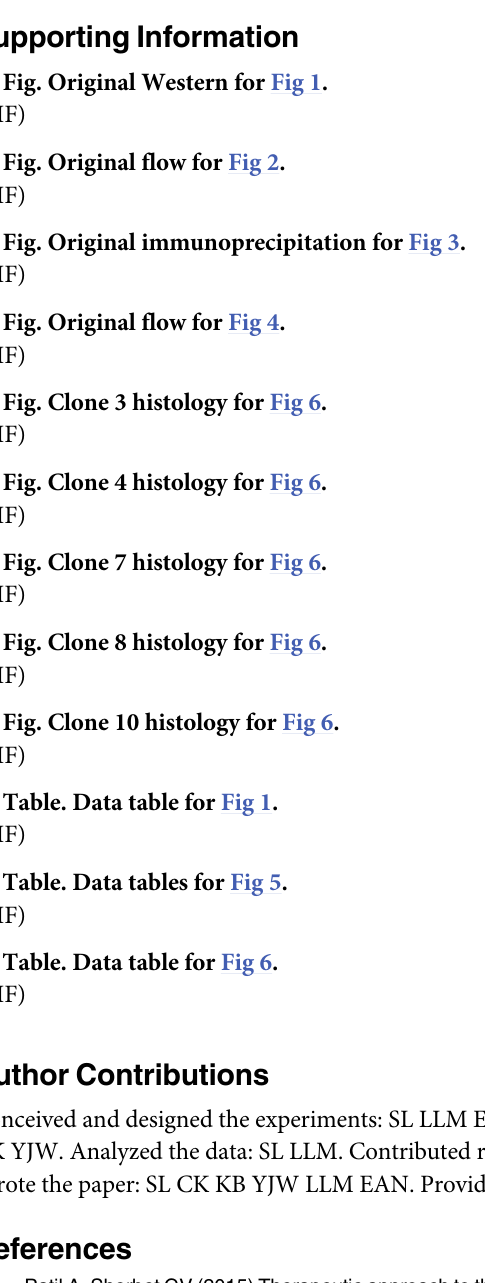
S1 Fig. Original Western for Fig 1. S2 Fig. Original flow for Fig 2. S3 Fig. Original immunoprecipitation for Fig 3. S4 Fig. Original flow for Fig 4. S5 Fig. Clone 3 histology for Fig 6. S6 Fig. Clone 4 histology for Fig 6. S7 Fig. Clone 7 histology for Fig 6. S8 Fig. Clone 8 histology for Fig 6. S9 Fig. Clone 10 histology for Fig 6. S1 Table. Data table for Fig 1. S2 Table. Data tables for Fig 5. S3 Table. Data table for Fig